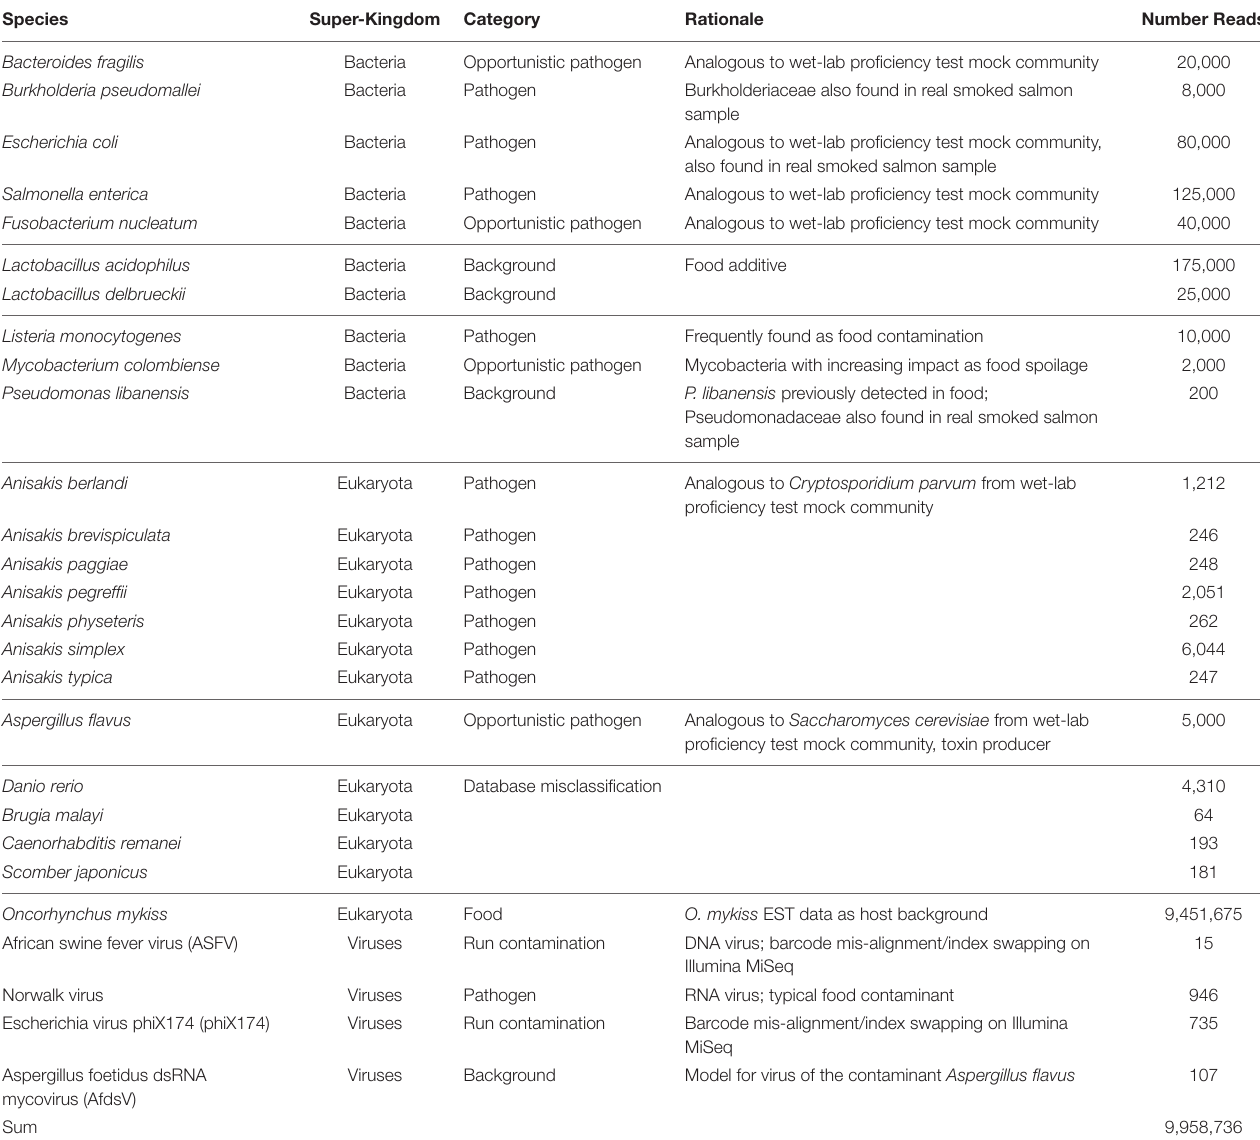
TABLE 1 | Composition of the simulated sequence dataset.